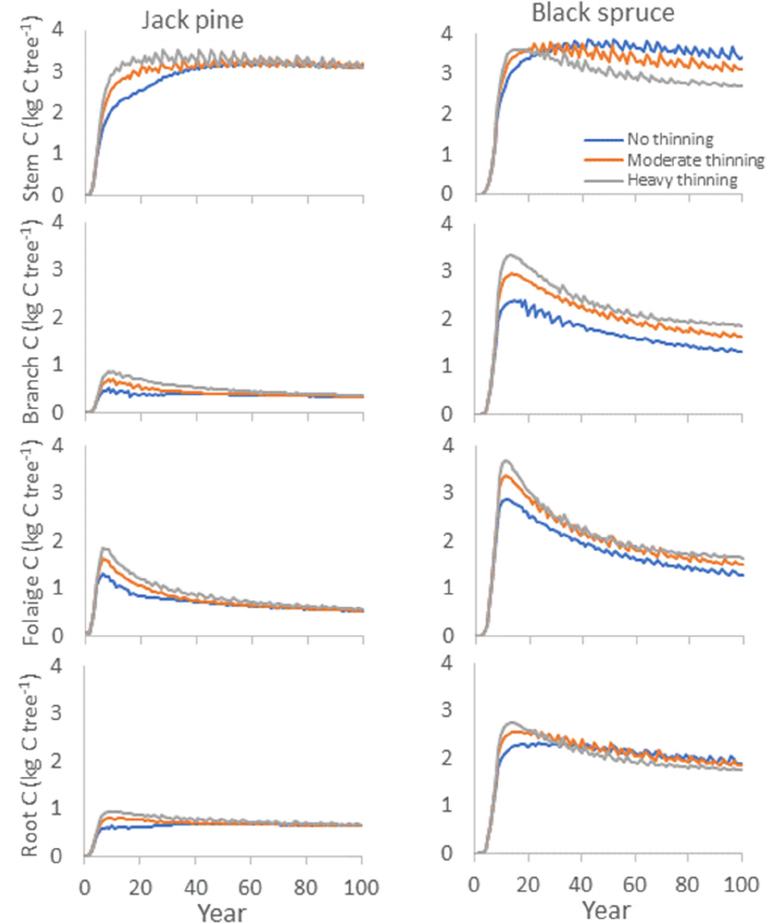
Figure 5. Simulated carbon allocation for different thinning intensities at a tree scale in foliage, branches, stem, and roots for jack pine and black spruce. The simulated thinning intensities include no thinning (6000 stem·ha − 1 ), moderate thinning (4000 stem·ha − 1 remaining in the stands), and heavy thinning (3000 stem·ha − 1 remaining in the